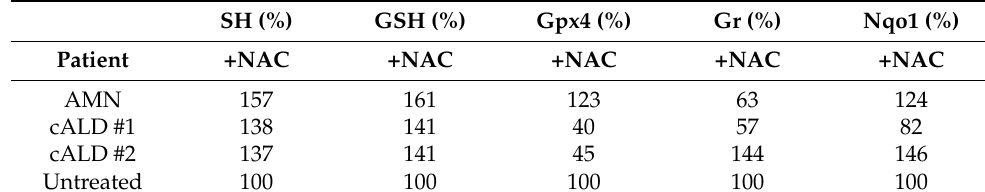
Table 4. Glutathione and proteins levels in NAC-treated patients expressed as percentage respect to untreated ones.